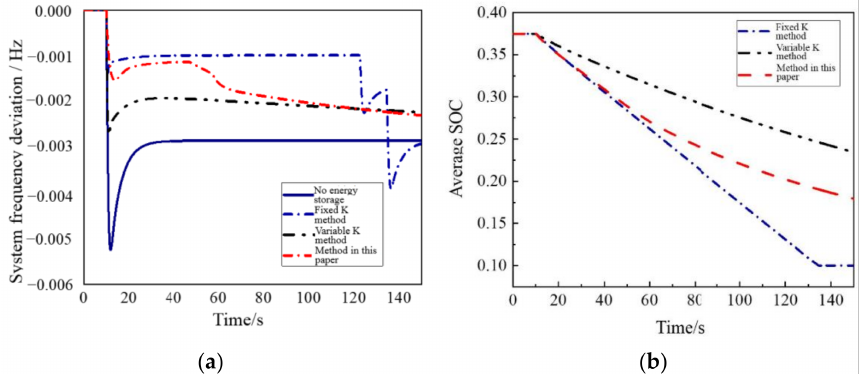
Figure 5. Response curve of frequency and SOC: ( a ) frequency response curve; ( b ) average SOC change